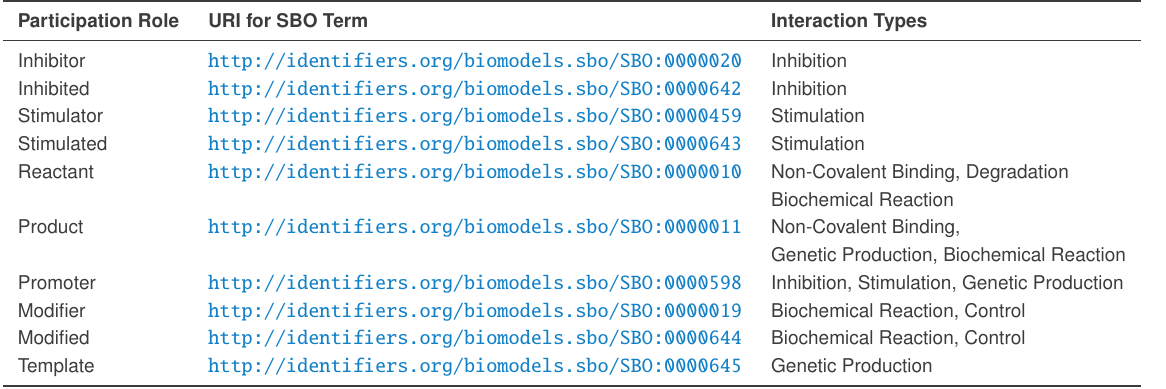
Table 11: Partial list of SBO terms to specify the role properties of a Participation .